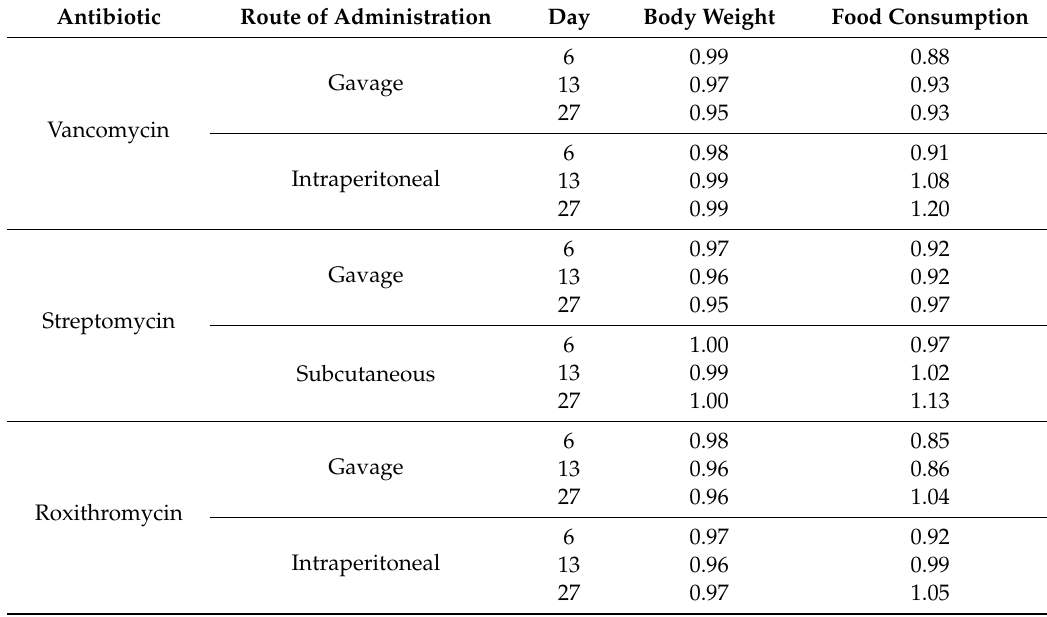
Table 1. Fold changes in body weight and food consumption of Crl / Wi(Han) rats ( n = 5) dosed for 28 days compared to the corresponding feeding controls ( n = 10 per group). None of the relative decreases in body weight compared to corresponding feeding controls were statistically significant ( p <